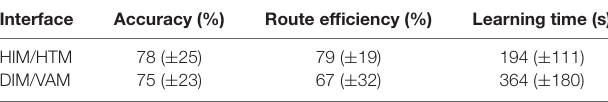
TABLE 2 | Mean participant data ( ± 1 SD) for accuracy, route efficiency, and learning